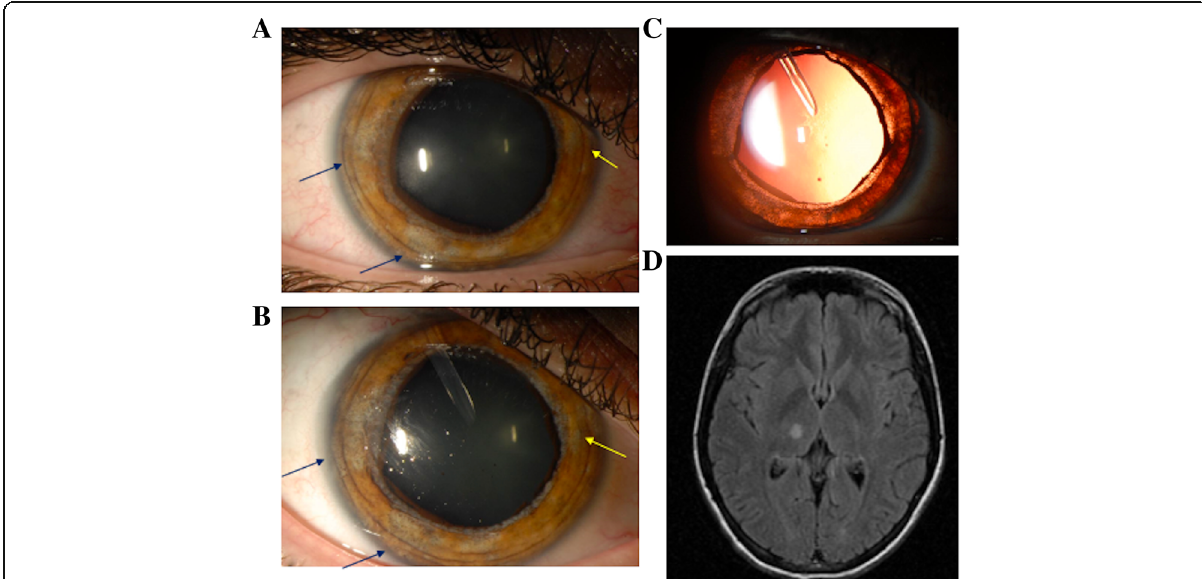
Fig. 1 Slit-lamp photo showed multifocal patches of iris atrophy temporally (blue arrows) and nasally (yellow arrow) at presentation ( a ). The areas of atrophy enlarged with increased pigment deposition at follow-up ( b ). These areas are readily visualized as diffuse transillumination defects with retroillumination (i.e. orange/red reflex off the retinal surface) which is visualized through the atrophic iris stroma and epithelium ( c ). A T2 FLAIR magnetic resonance image after the patient ’ s stroke showed lacunar infarcts within the right thalamus ( d